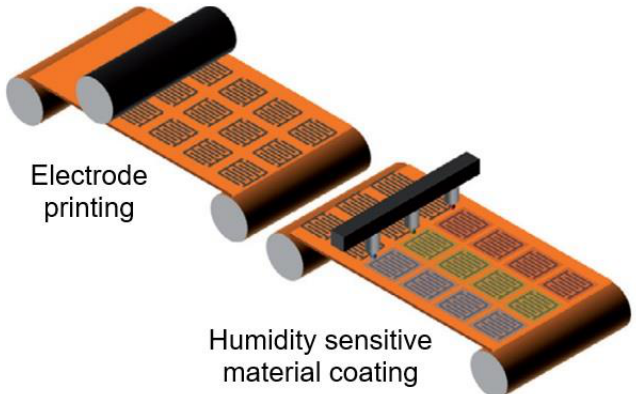
Figure 1. Schematic drawing of a roll-to-roll production line for chemical gas and humidity sensors on plastic foil. The transducers and coating layers are coated using additive printing techniques, such as the gravure printing of interdigitated electrodes and the local ink-jet printing of different sensing layers. Reprinted from [3]. Published 2011 by Elsevier as open access.